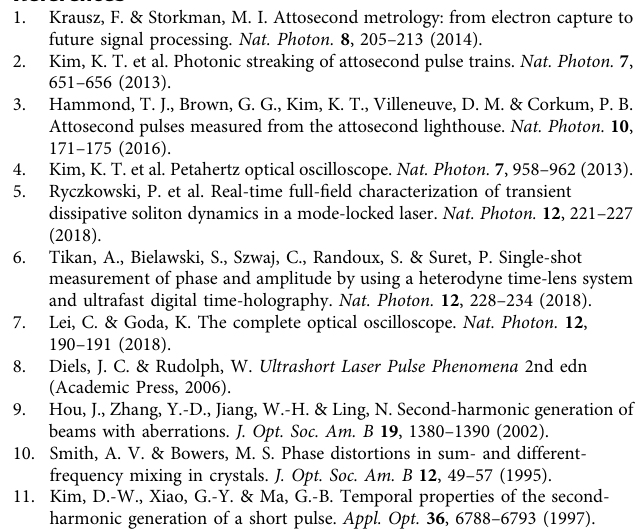
Fig. 4 Feasibility of real-time PHz oscilloscope. a Controlling the single-shot time window ( W ) on the screen and the temporal resolution per single pixel ( R ) of our oscilloscope. The three green boxes indicate different interaction regions of the Q-1D electron array and input optical signal at the Cu slit, where L e ; gap is the horizontal length of the electron beam passing through the gap. The focusing strength ( current of the quadrupole magnet. b , c Measured data (dots) and linear fi ts (solid curves) of L e ; gap , W , and R as a function of k . The black arrows correspond to the three experimental images in ( a